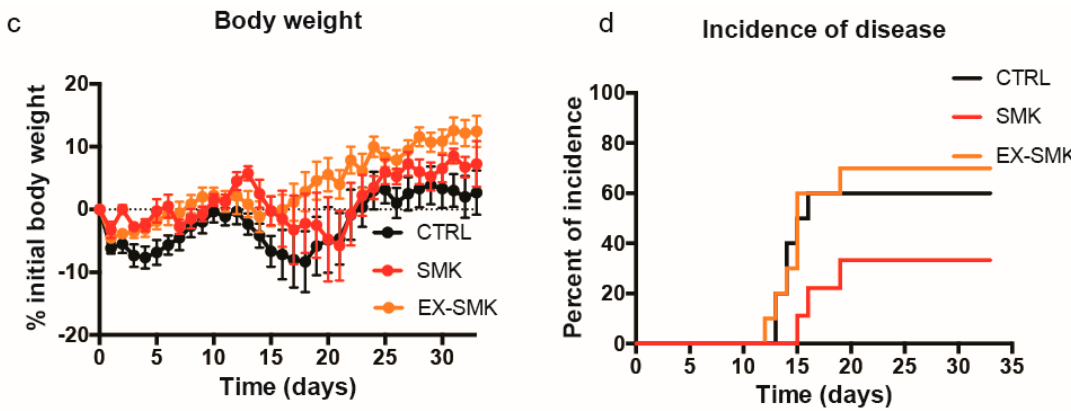
Figure 7. Cigarette smoke exposure ameliorates clinical EAE in C57BL/6J mice. Groups of C57BL/6J females were exposed to room air or cigarette smoke as shown in Figure 3. Clinical score ( a ), disease severity ( b ), body weight ( c ), and disease onset ( d ) are shown following immunization with MOG aa35–55 ( n = 9–10 mice/group). Disease severity based on clinical scores was compared by calculating the area under the curve (AUC). Data are shown as mean ± SD ( a – c ) including individual values in ( b ). Individual values “score 0” are not shown for better visibility. Differences between the groups for disease severity (AUC) showed no statistical differences using one-way ANOVA. A Kaplan-Meier curve for disease incidence showed a significant reduction for the SMK group compared to CTRL using log rank test ( p < 0.05).